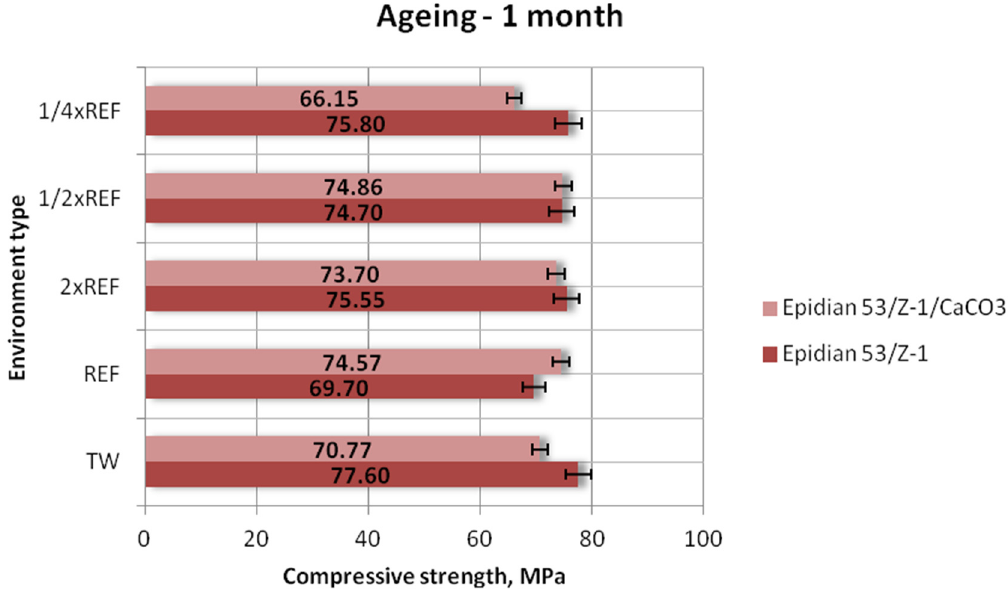
Figure 4. Compressive strength of the unmodified (Epidian 53 / Z-1) and modified (Epidian 53 / Z-1 / CaCO 3 ) adhesive compounds, aged for 1 month.